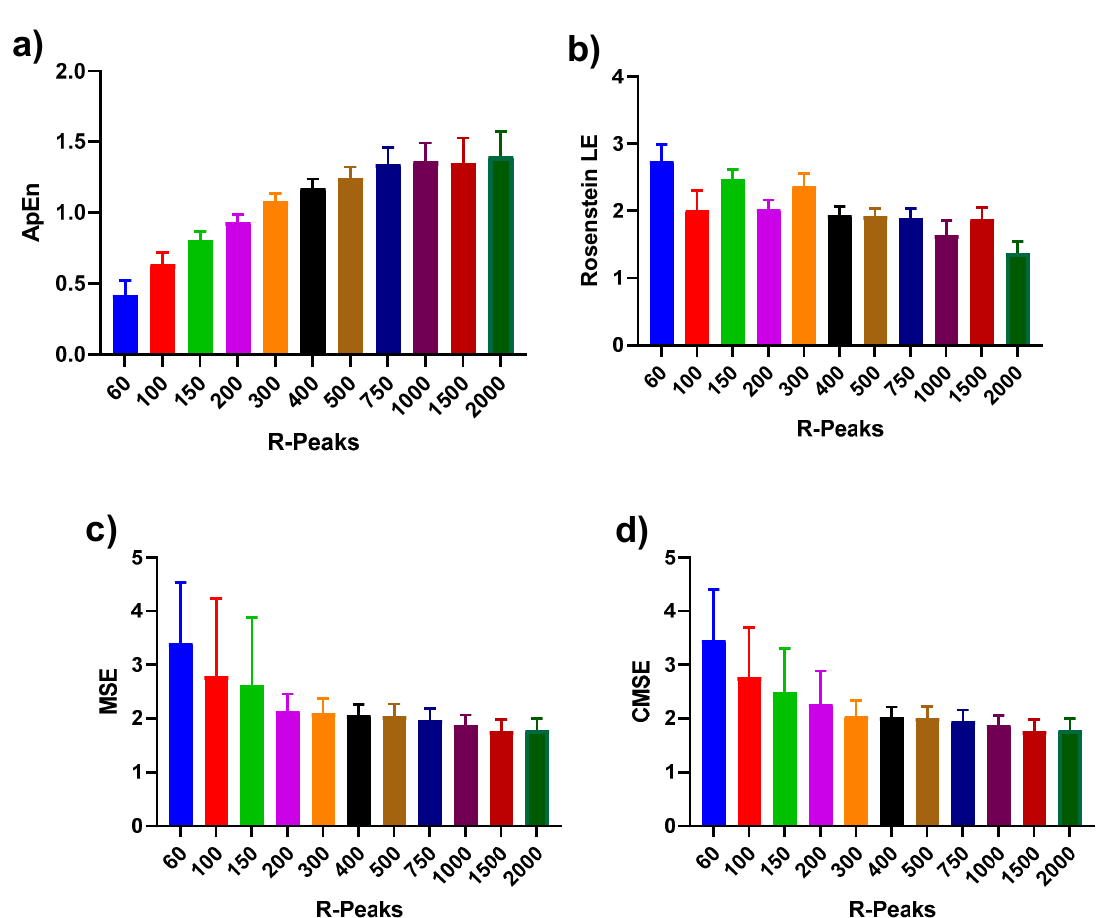
Figure 4. Bar plots of ( a ) ApEn, ( b ) Rosenstein’s LE, ( c ) MSE, and ( d ) CMSE with different numbers of R peaks. Different R-peaks are represented with different colors for four nonlinear methods. The error bars represent standard deviation (SD) of the values among 14 participants.